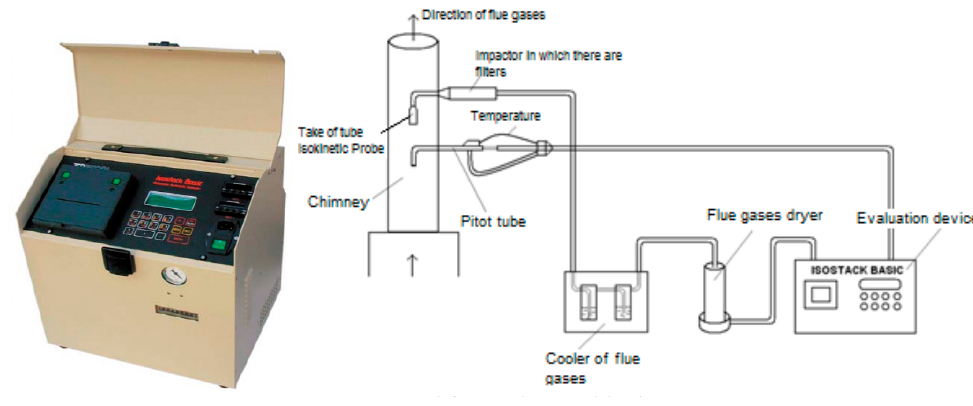
Figure 3. ISOSTACK BASIC HV automatic lifter and assembly diagram [40].